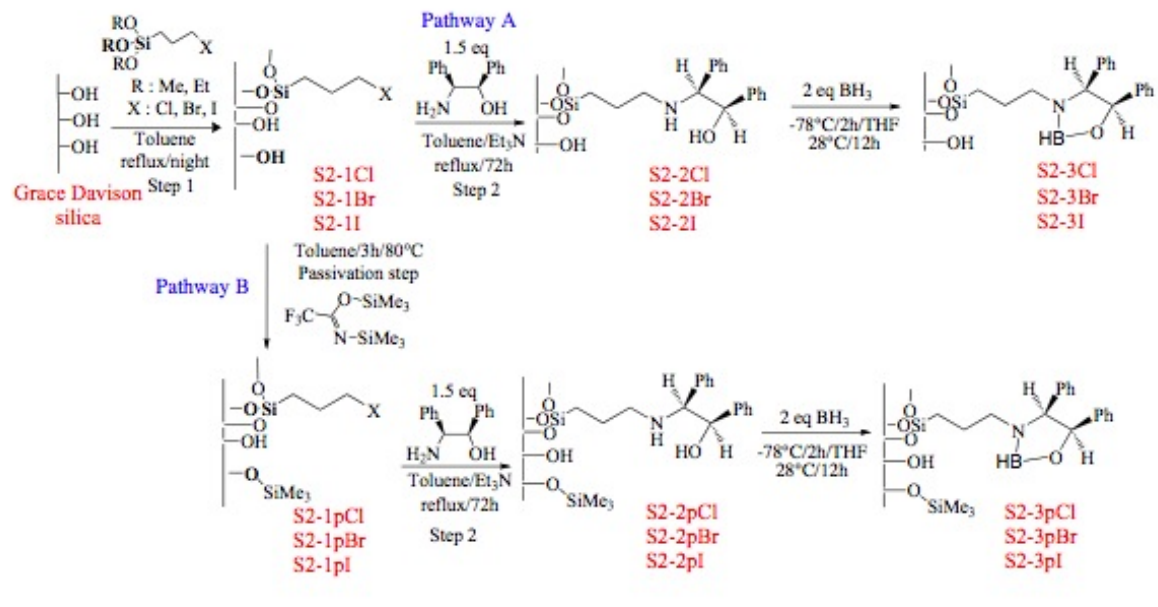
Figure 6. Immobilization of oxazaborolidine via nitrogen